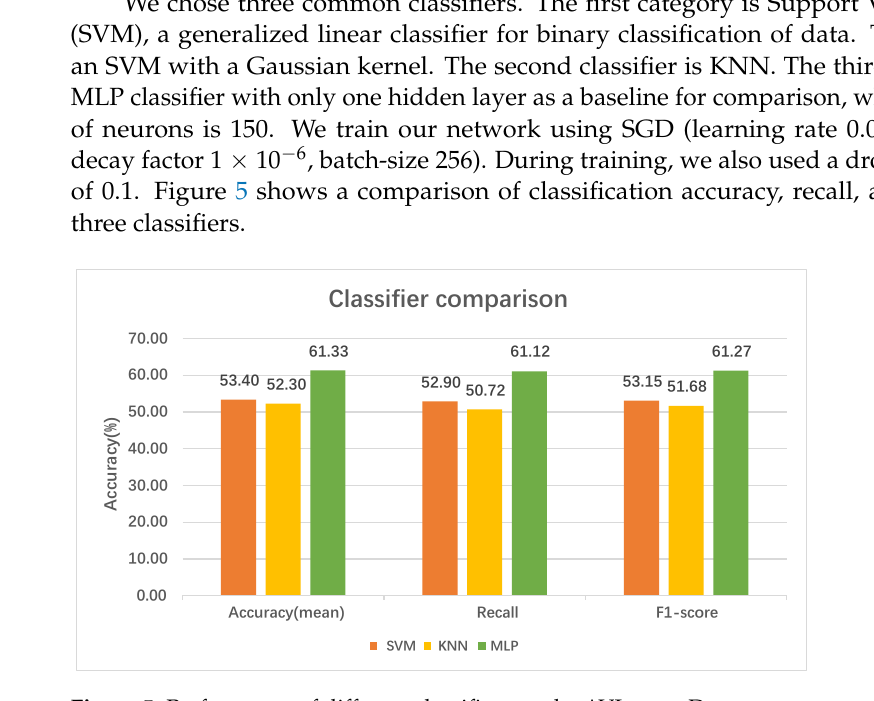
Figure 5. Performance of different classifiers on the AVLetters